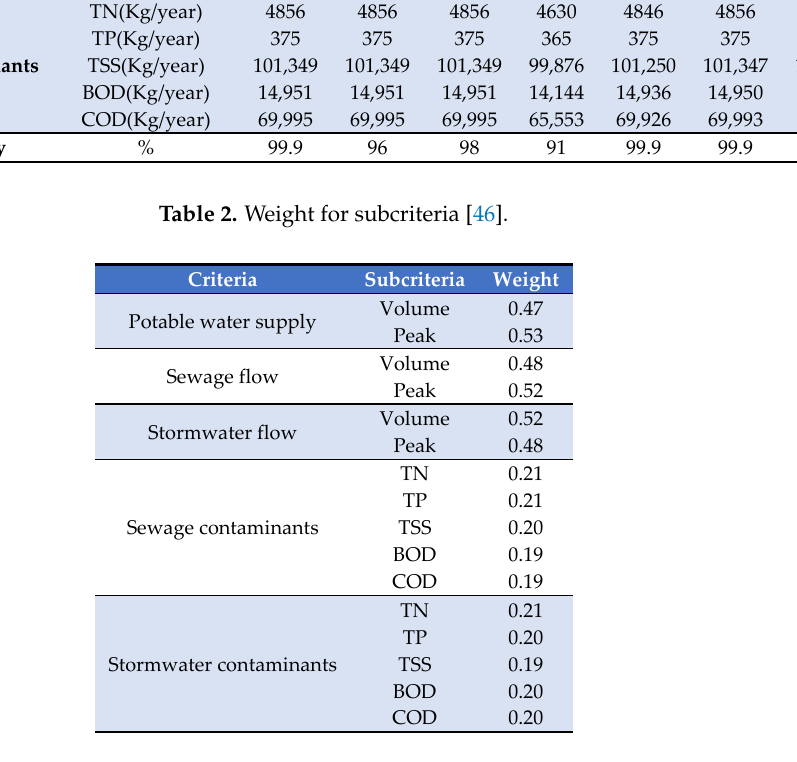
Figure 2 . Usual criterion (Type I) preference function.